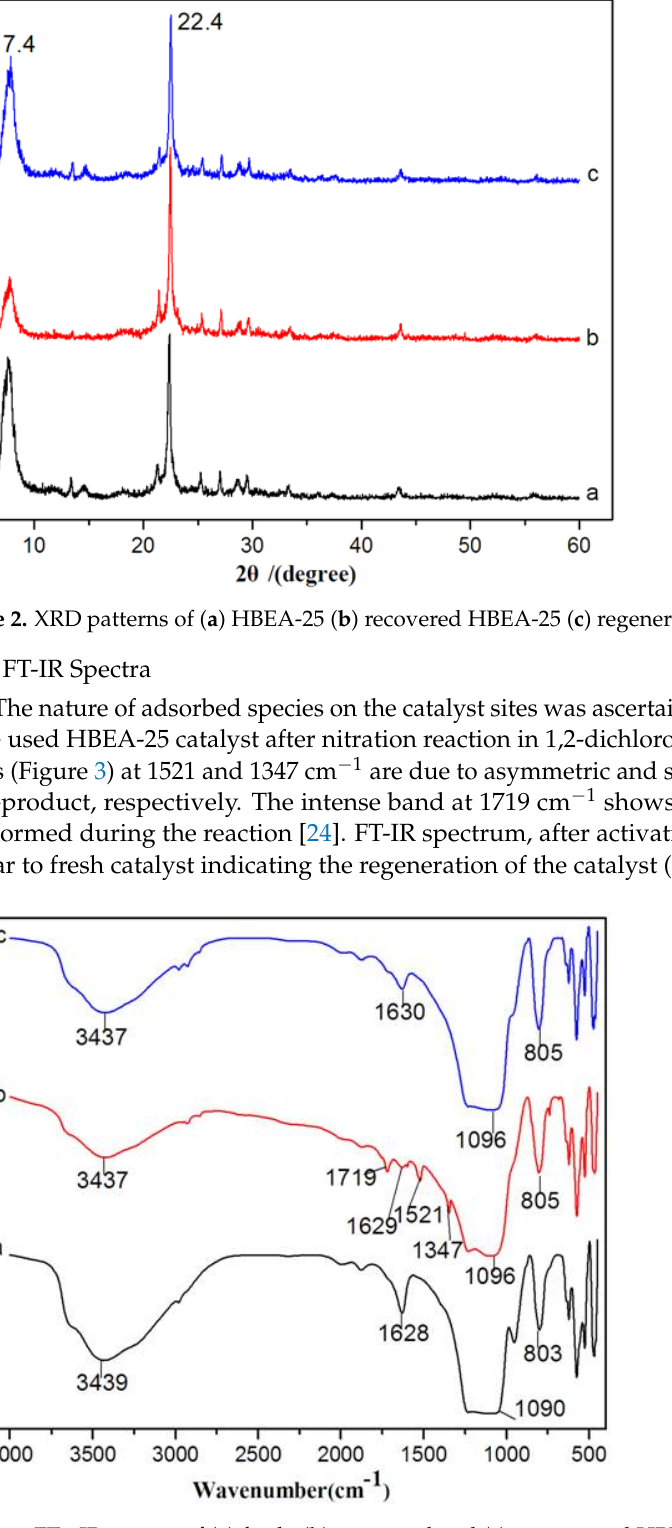
Figure 3. FT − IR spectra of ( a ) fresh, ( b ) recovered and ( c ) regenerated